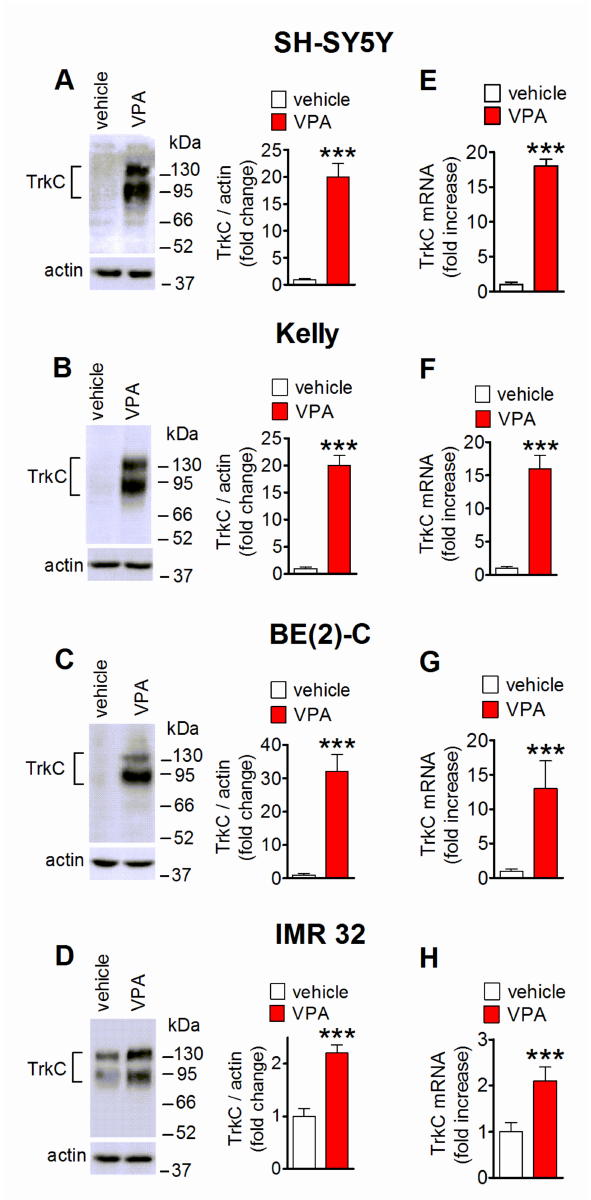
Figure 1. VPA upregulates TrkC expression in human neuroblastoma cell lines. ( A – D ) Cells were treated with either vehicle or 1 mM VPA for 24 h and then analyzed for TrkC protein levels by Western blot. Values are the mean ± SD of five ( A ) and four ( B – D ) independent experiments. The position of molecular mass standards is indicated on the right side of each blot. ( E – H ) Quantitative real-time reverse transcription polymerase chain reaction (qRT-PCR) analysis of TrkC mRNA in cells treated for 24 h with either vehicle or 1 mM VPA. Values are the mean ± SD of four independent experiments. *** p < 0.001 vs. control (vehicle-treated cells) by Student’s t